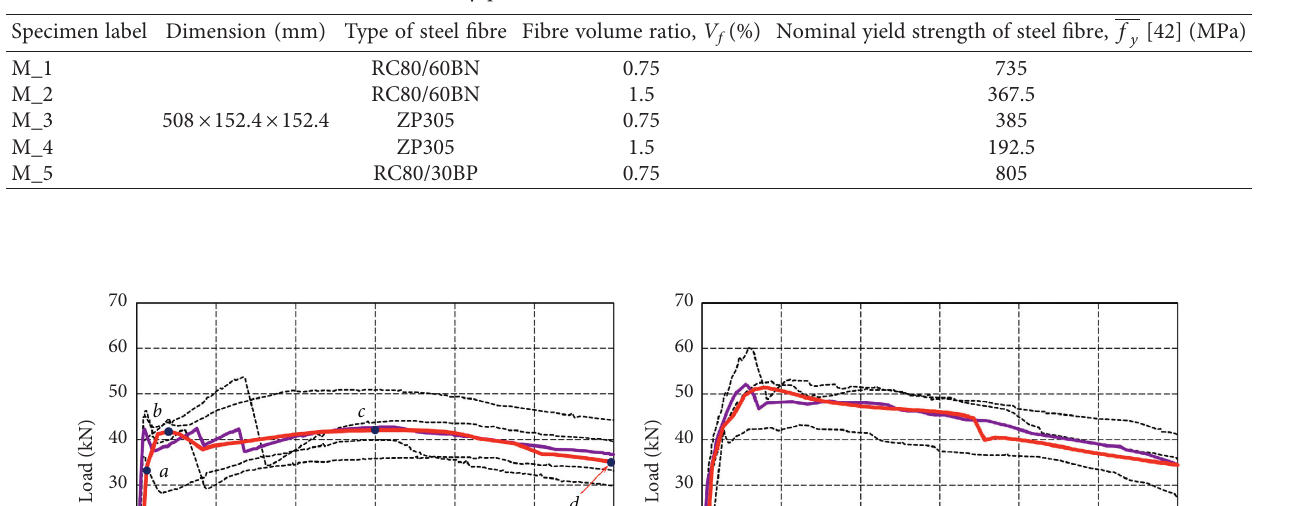
Table 3: Primary parameters of steel fibre concrete flexural